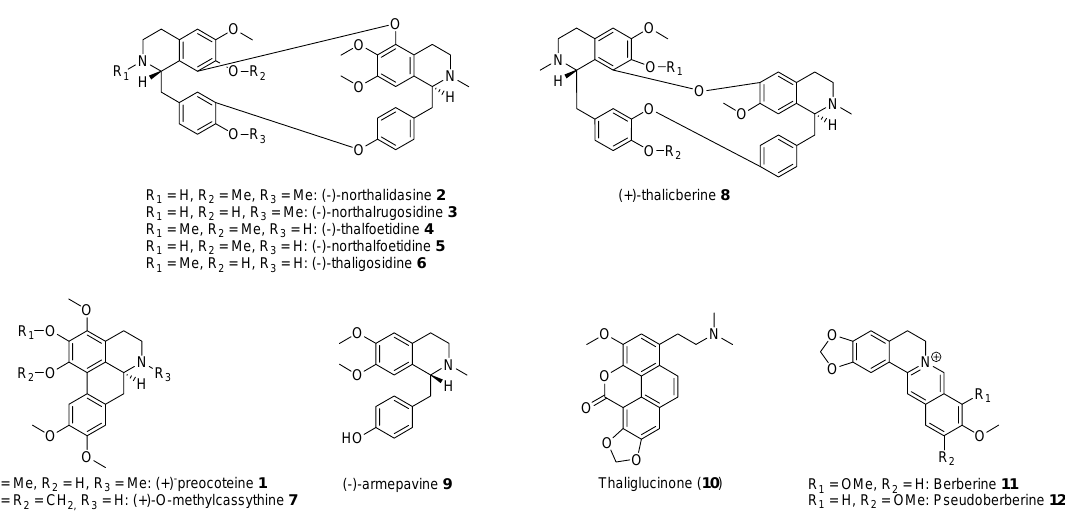
Figure 1. Isoquinoline alkaloids isolated from Thalictrum flavum L.